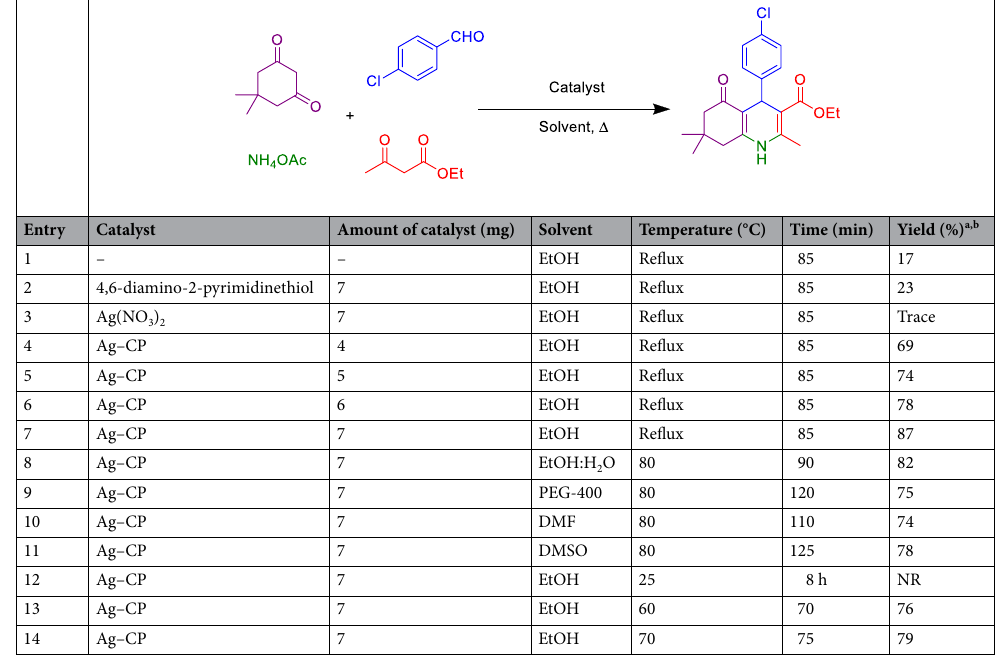
Table 1. Optimization of the reaction conditions for the Hantzsch condensation of para -Chlorobenzaldehyde, dimedone, ethyl acetoacetate and ammonium acetate as a model reaction for the synthesis of polyhydroquinolines. a Isolated yield. b Reaction conditions: 4-Chlorobenzaldehyde (1 mmol),